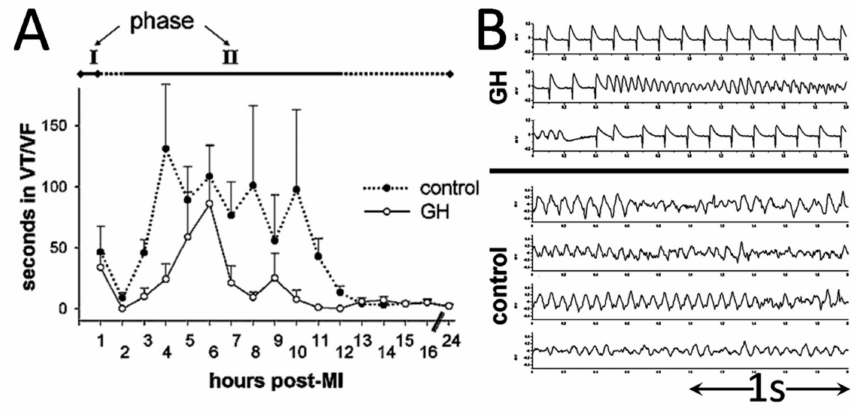
Figure 2. Ventricular tachyarrhythmias during acute infarction. ( A ) The total duration of tachyarrhythmias was shorter in the GH-treated group, mainly during phase II. Representative examples areshowninpanel( B )FromElaiopoulosetal. Clin. Sci. (Lond), 112(2007)385–391[12],